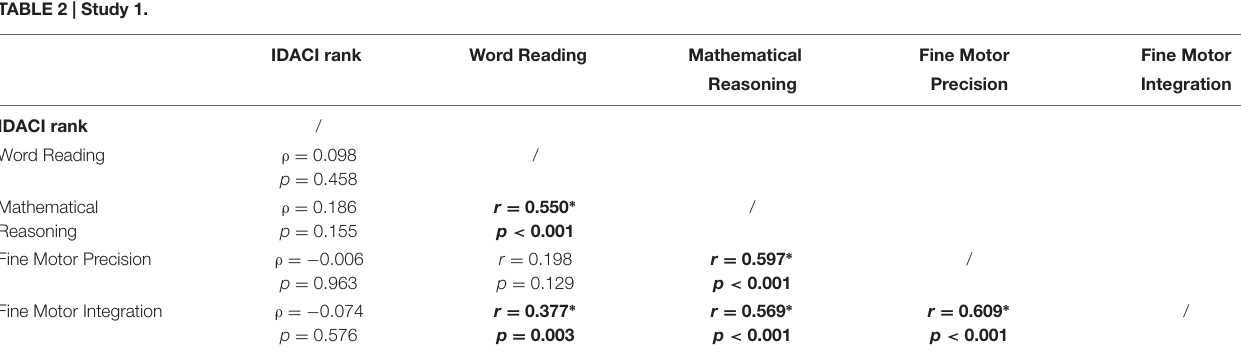
TABLE 2 | Study 1.